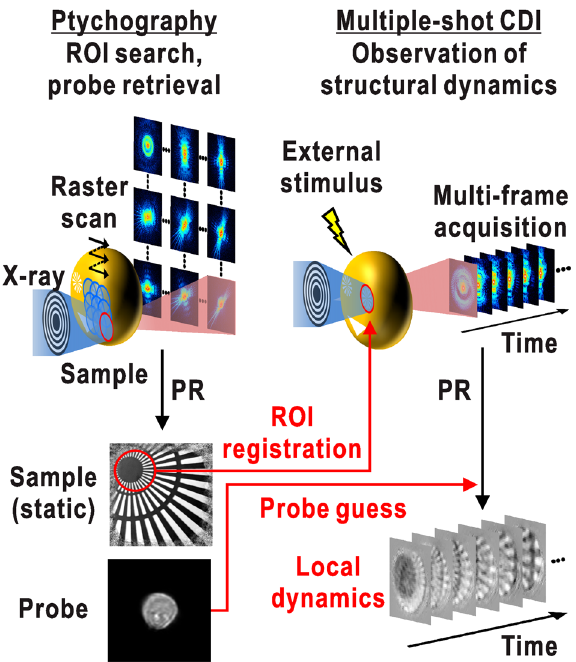
Fig. 1 Strategy for visualising local structure and dynamics of an extended object. Prior to initiating the dynamics, a region-of-interest (ROI) on the sample is searched by ptychographic imaging. The structural change of the sample is initiated with external stimulus, and the sample is imaged by multiple-shot coherent diffraction imaging (CDI). Diffraction patterns of the registered ROI are collected during the dynamics and supplied to the dedicated phase retrieval (PR) algorithm to reconstruct the temporal stack of object frames. The illumination probe retrieved by ptychography is used in the